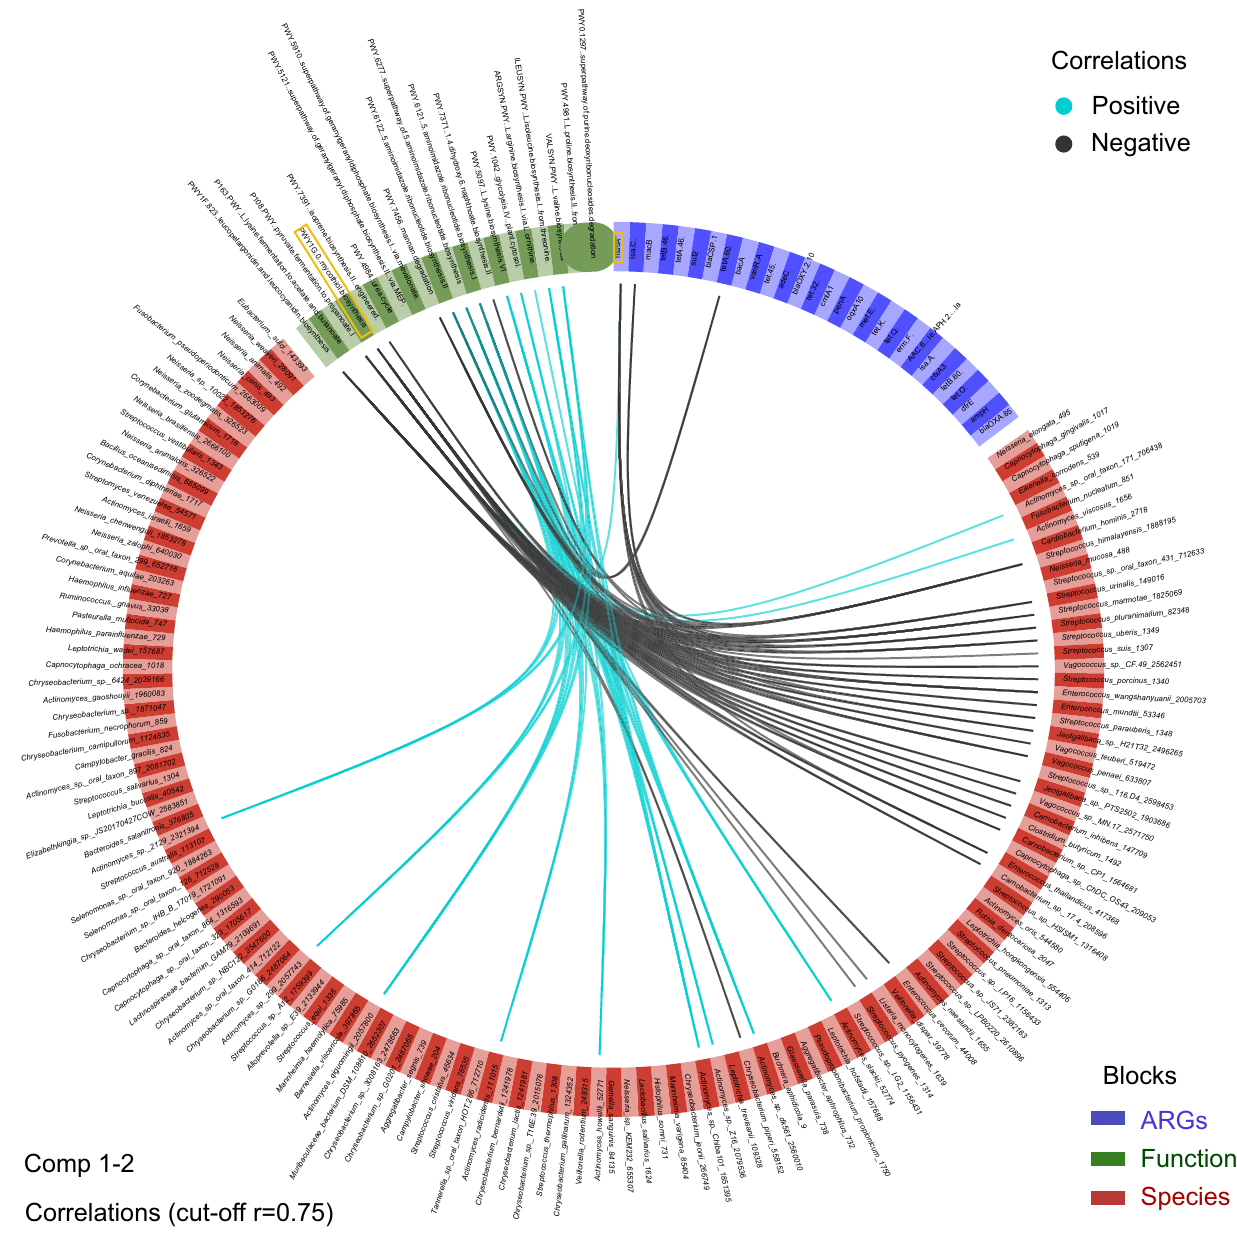
plot are correlations ≥ 0.75 between the different data types. Yellow boxes around text labels for macA and mycothiol biosynthesis indicate an ARG-function of interest correlation that contributes to clustering by time point/stage of dental development (Fig.